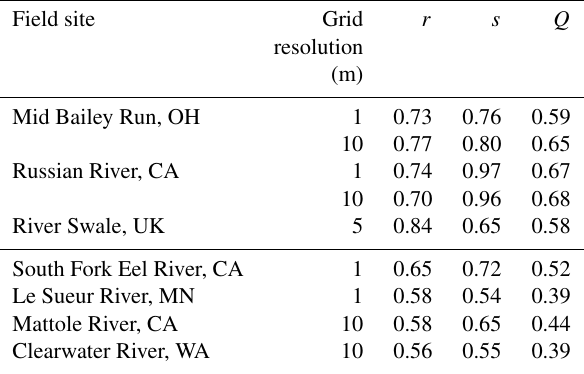
Table 4. Results of the reliability ( r ), sensitivity ( s ), and overall quality ( Q ) analysis for each